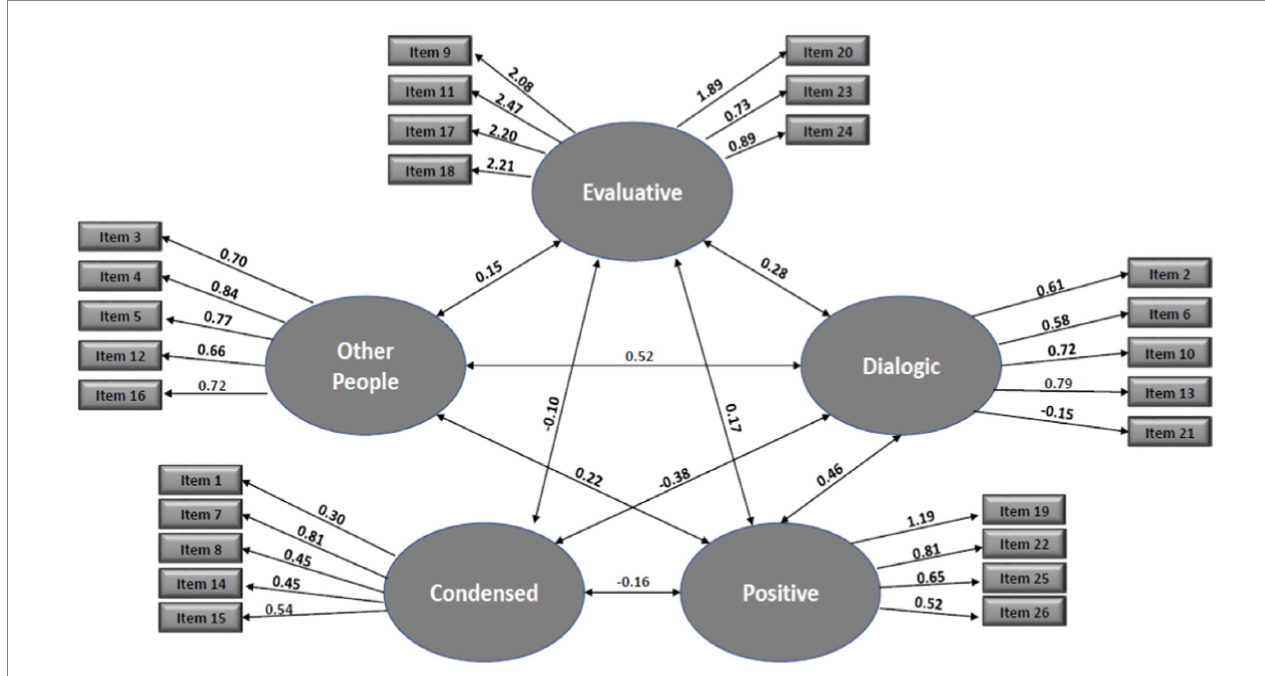
FIGURE 1 CFA of the five-factor model of the VISQ-R—Hebrew version. Ellipses indicate latent variables. Rectangles indicate observed variables. Arrows between latent variables indicate significant correlations between latent variables. Correlations between latent and observed variables were significant at p < 0.01.